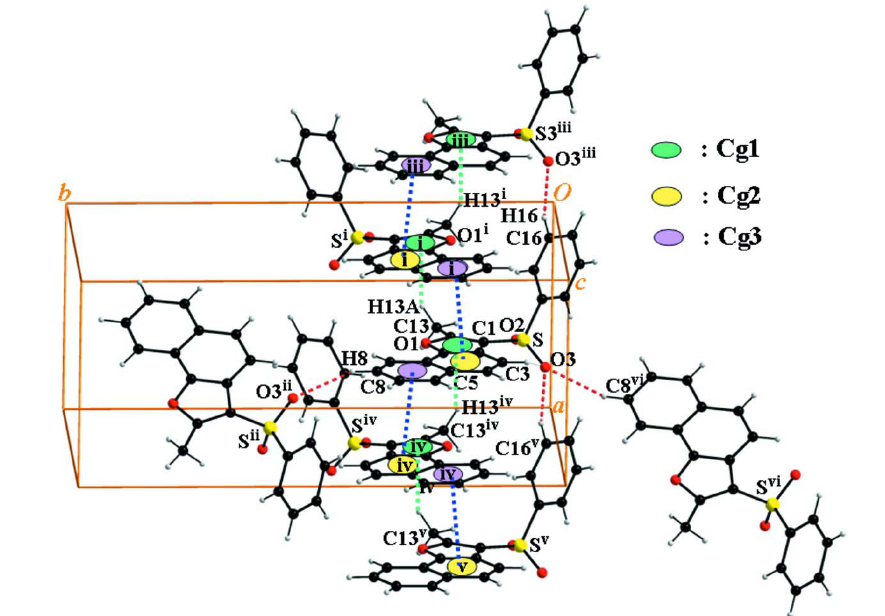
Figure 2 π — π , C—H··· π and C—H···O interactions (dotted lines) in the title compound [symmetry codes: (i) x - 1/2, - y + 1/2, z ; (ii) - x + 3/2, y + 1/2, z - 1/2; (iii) x - 1, y , z ; (iv) x + 1/2, - y + 1/2, z ; (v) x + 1, y , z ; (vi) - x + 3/2, y - 1/2, z +